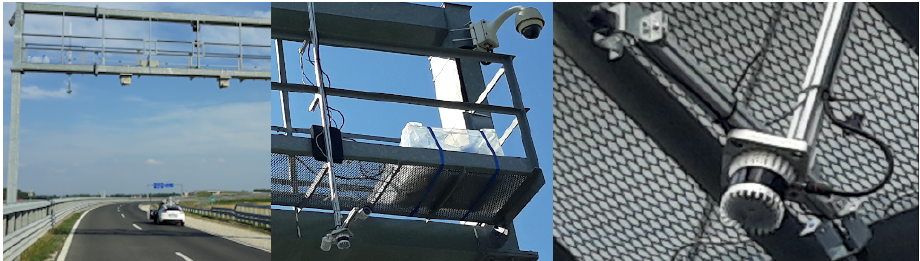
Figure 10. Infrastructure setup. Left to right: Infra1 from a distance, Infra1 from the other side, and Infra2 sensors